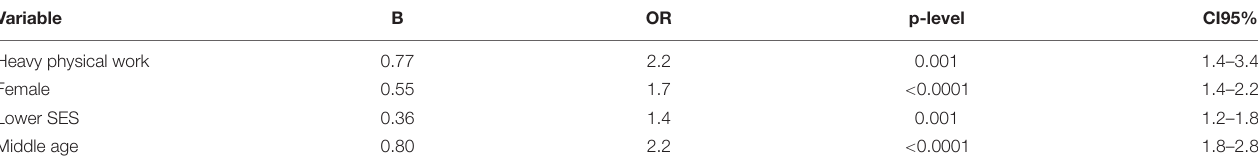
TABLE 3 | Logistic regression model for prediction of difficulty falling